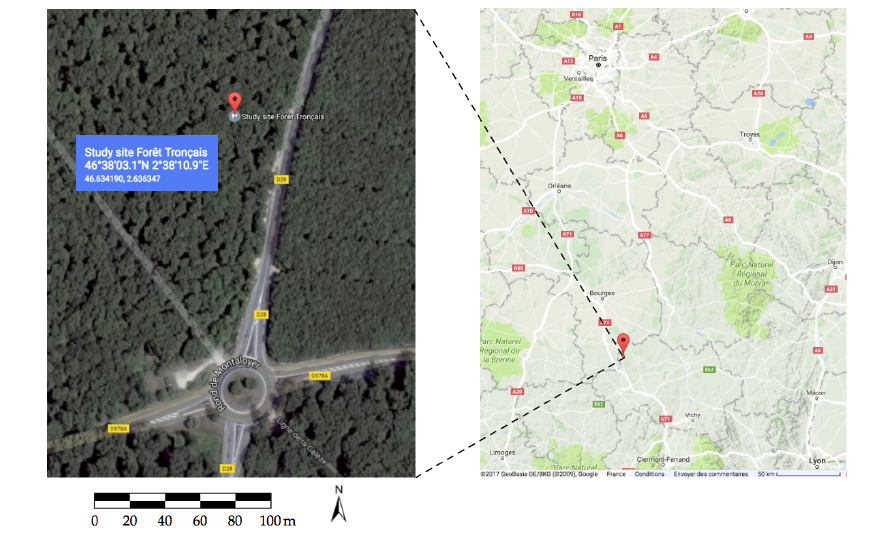
Figure 3. Study site Forêt de Tronçais in the Auvergne-Rhone-Alpes region (département de l’Allier) of Central France. Source: Google Maps, 19 August 2017.